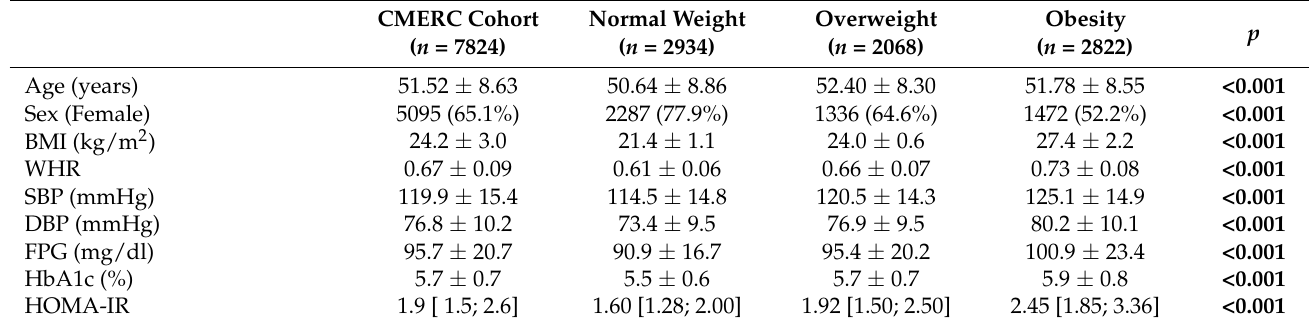
Table 1. Baseline Characteristics of the Study